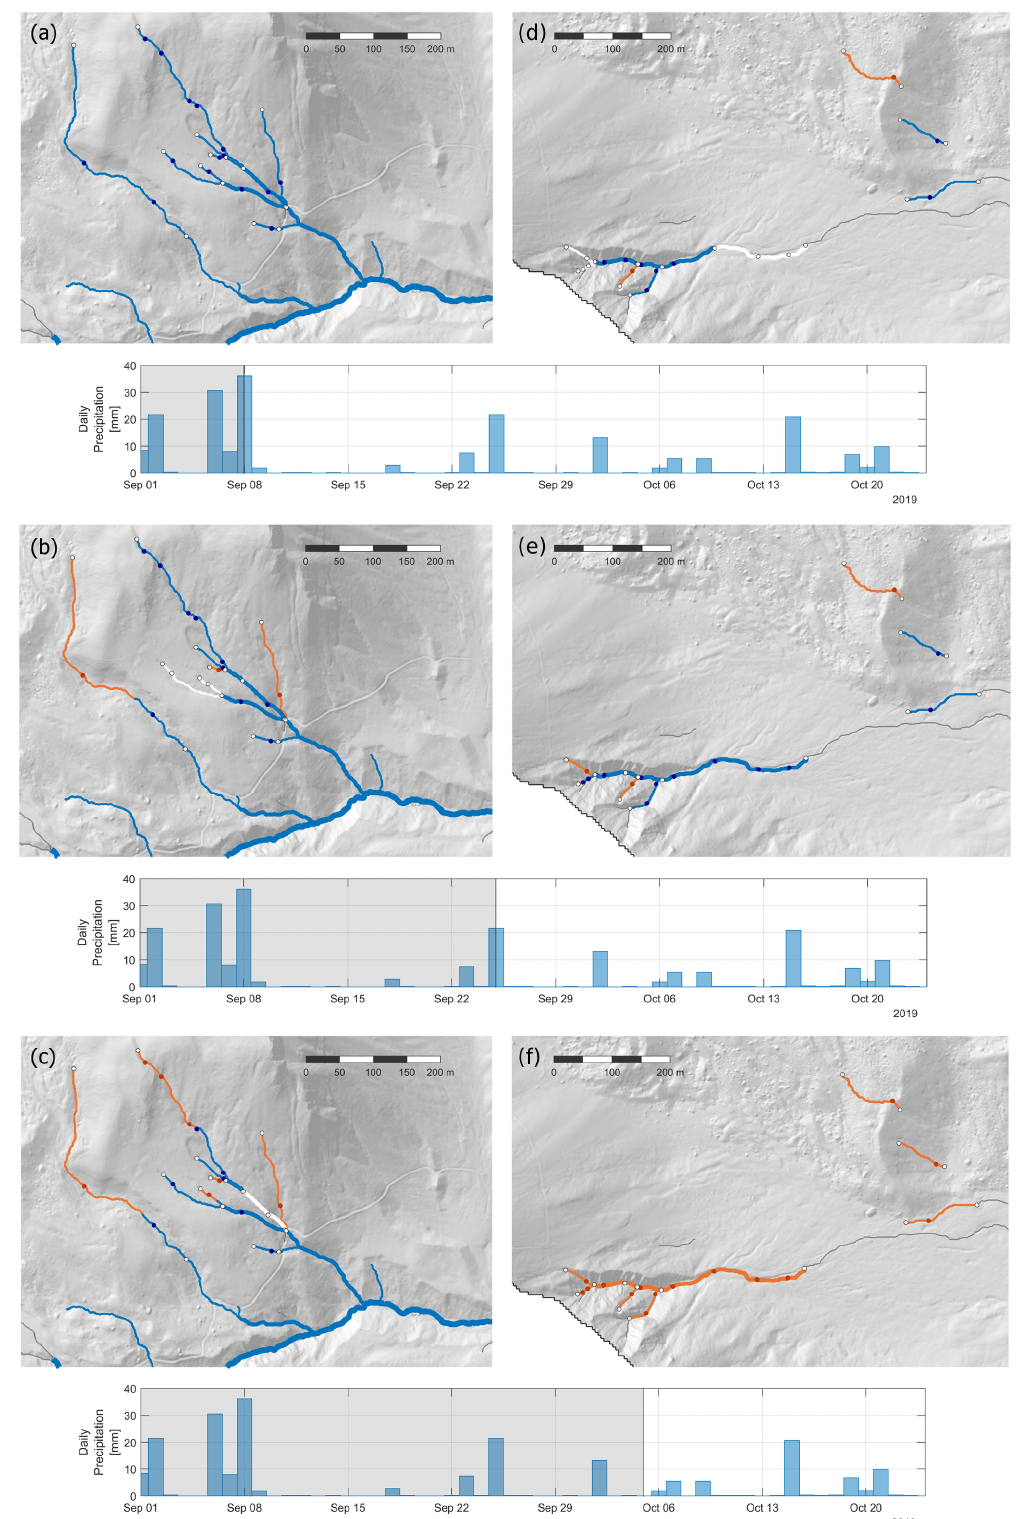
Figure 5. Map of the active stream network of Zone 1 (left column) and Zone 2 (right column) on 8 September (a, d) , on 25 September (b, e) and on 5 October (c, f) . Active stretches and sensors are blue, inactive ones are orange and no-data elements are white.